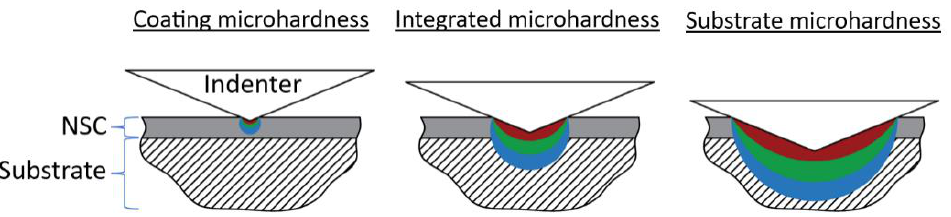
Figure 5. Graphical representation of micro-indentation depths: coating microhardness, integrated microhardness, and substrate microhardness. Colored curves represent internal stress in the material caused by the micro-Vickers indenter.